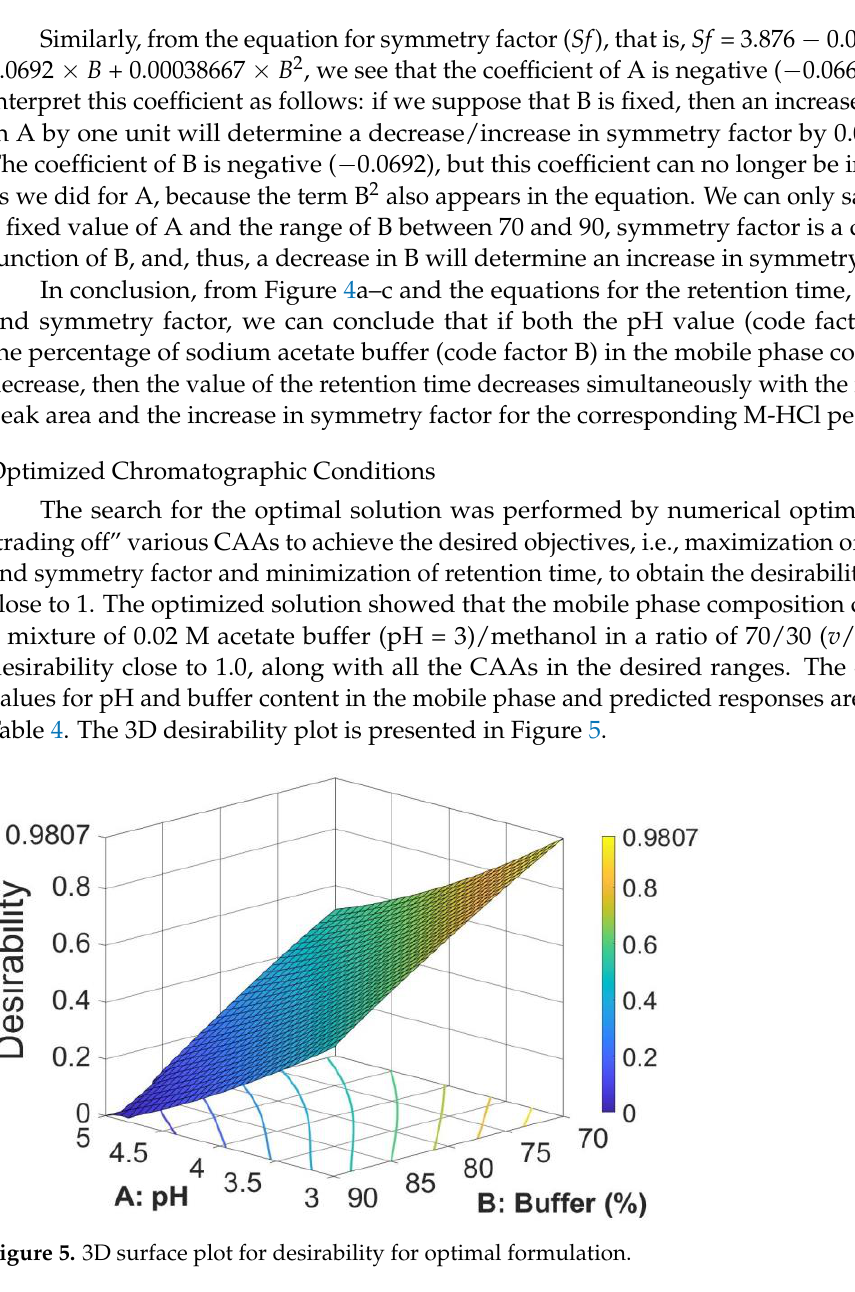
Table 5. Final chromatographic conditions.